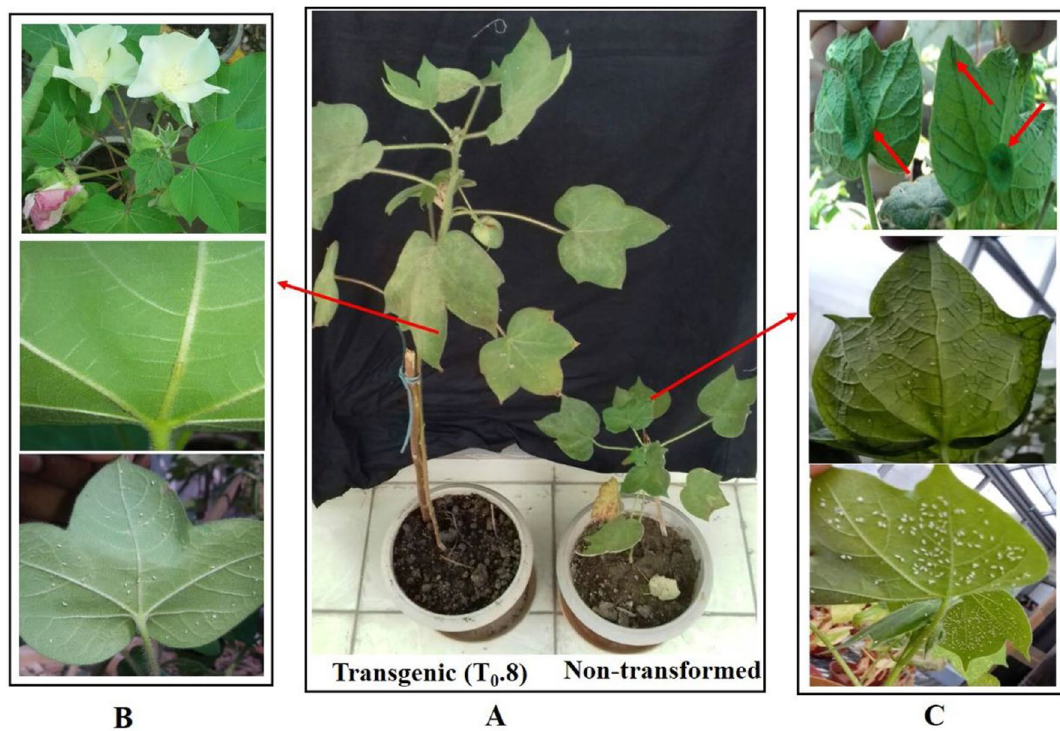
Figure 4. ( A ) Assessment of cotton leaf curl disease (CLCuD) symptoms in transgenic G. hirsutum cv. HS6 (T 0. 8) and non-transformed control plants after inoculation with viruliferous whiteflies ( Bemisia tabaci ) under greenhouse conditions. ( B ) No characteristic CLCuD symptoms developed on the leaves of transgenic lines 60 days post inoculation and transgenic plant showed normal phenotype. ( C ) CLCuD symptoms were developed on non-transformed control G. hirsutum var. HS6 plant such as vein thickening, leaf curling and enations were